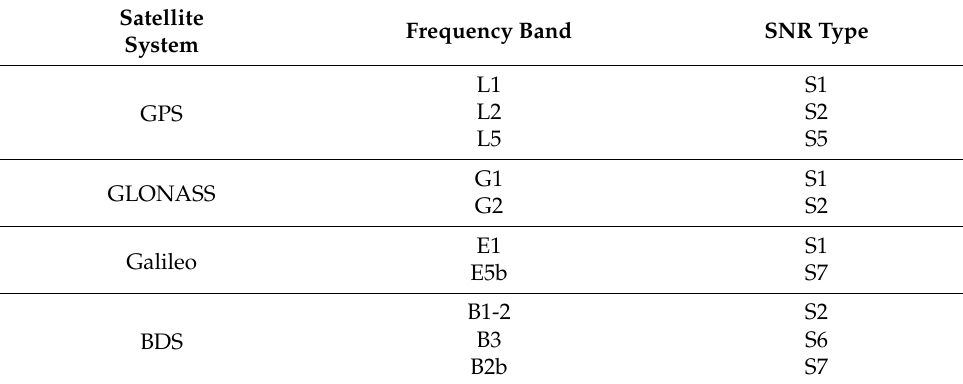
Table 1. Received SNR types for HNFQ.